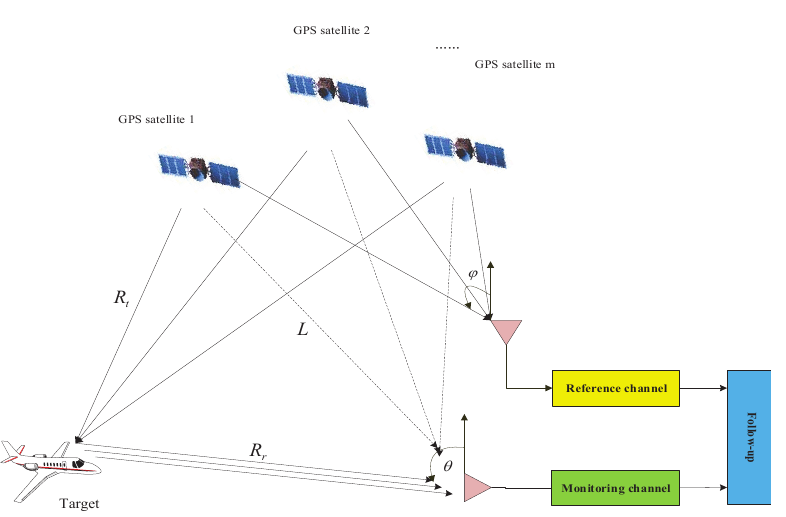
Figure 1. Passive detection based on multiple collaborative GPS satellites.